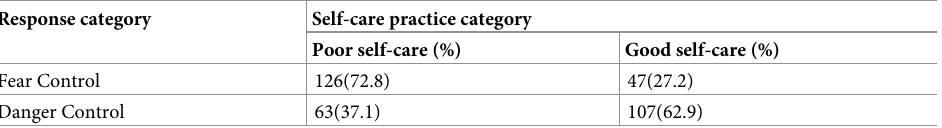
Table 5. Relationship between responses to diabetes self-care messages and self-care practices of patients with dia- betes in JUMC, Ethiopia April 12-May 25 2020 (n =